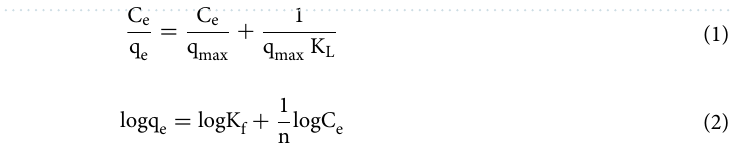
Figure 3. Impact of MPS-linker adsorbent loading on the CV and NR removal efficiency ( a ) and adsorption capacities ( b ), equilibrium isotherms ( c ), Langmuir ( d ) and Freundlich ( e ) models for CV and NR dyes adsorption on the synthesized MPS-linker